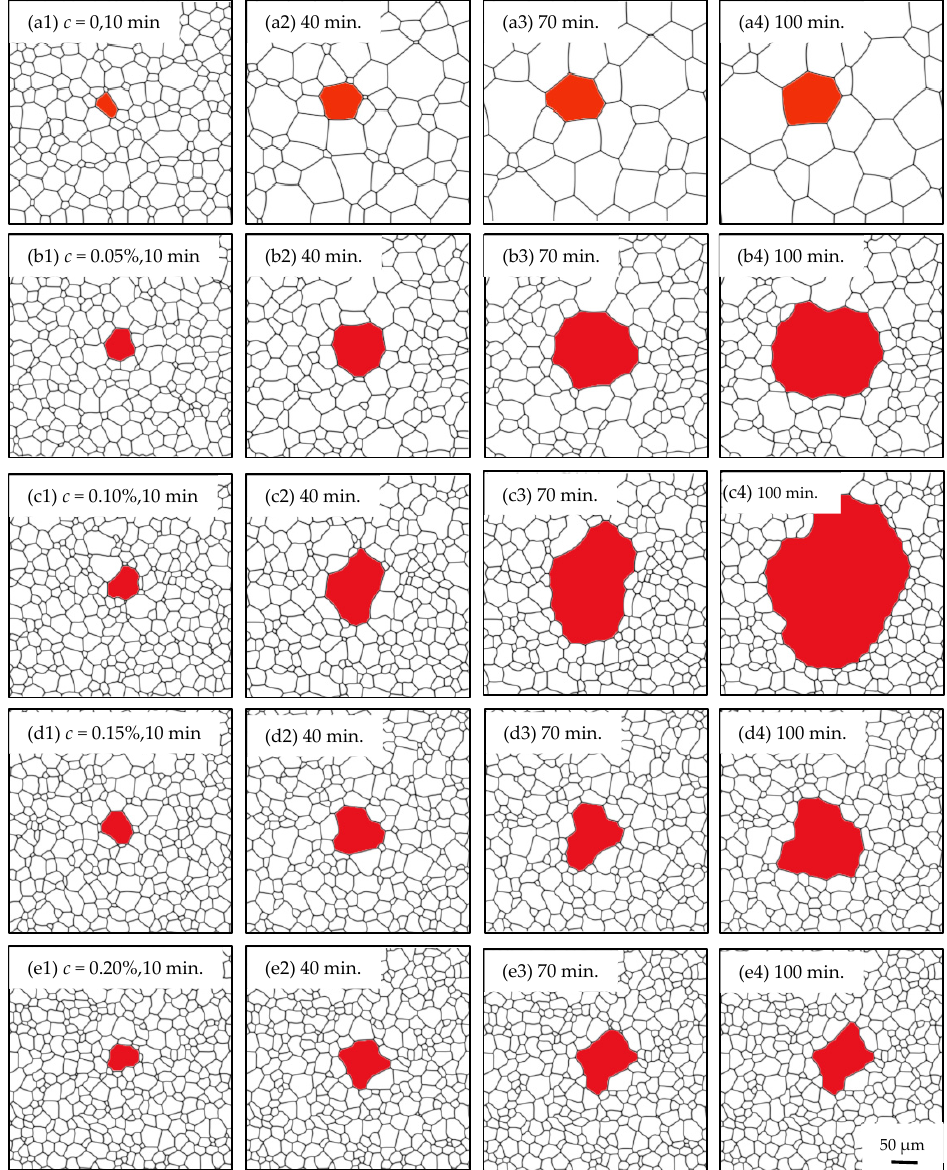
Figure 6. Microstructure evolution under different contents (0~0.20%) where T = 1273 and ω = 0.90. ( a 1 – a 4 ) c = 0, 10-100 min;( b 1 – b 4 ) c = 0.05%, 10-100 min;( c 1 – c 4 ) c = 0.10%, 10-100 min;( d 1 – d 4 ) c = 0.15%, 10-100 min;( e 1 – e 4 ) c = 0.20%, 10-100 min.